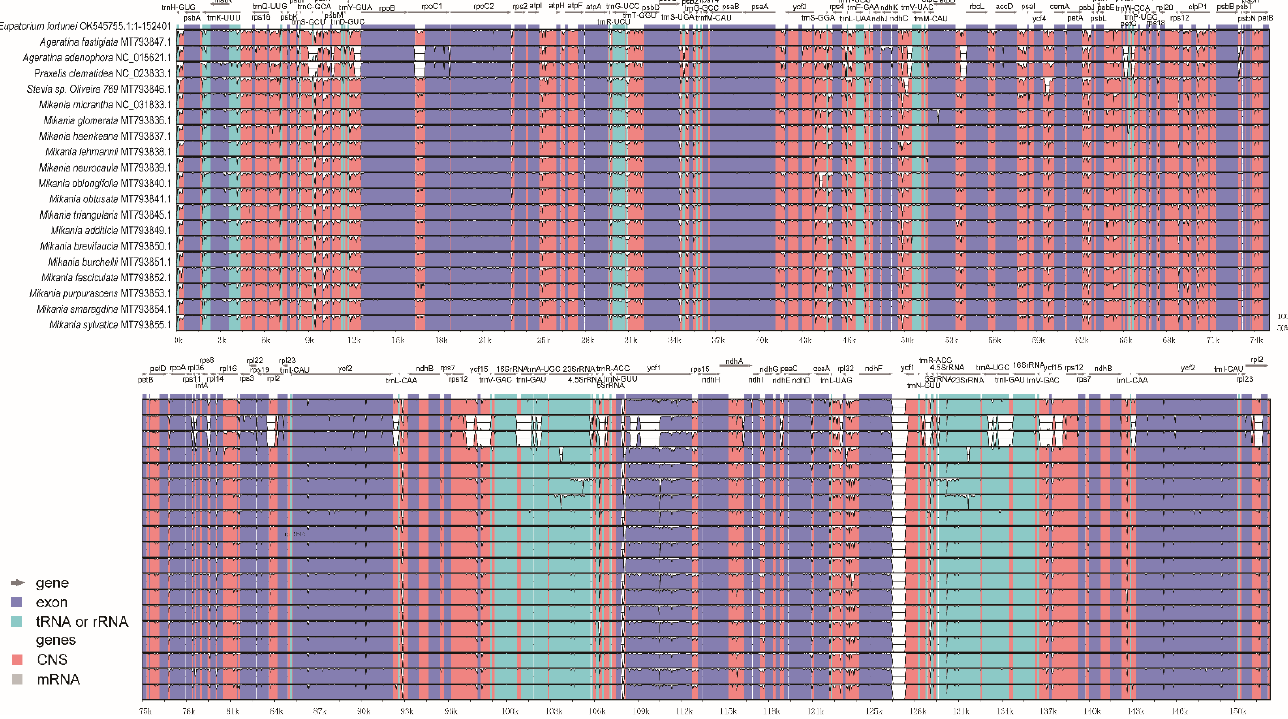
Figure 7. Percent identity plot for comparison of 19 Eupatorieae cp genomes using mVISTA. The x -axis represents the base sequence, and on the y -axis, percentage of sequence identity was shown between 50% and 100%. In contrast, coding exons and UTRs are marked with different colored rectangles. Conserved regions (defined below) are highlighted under the curves, red indicates conserved noncoding regions, blue indicates conserved exons, conserved UTRs are turquoise, and the direction of gene transcription is indicated by gray arrows. The pink bars represent noncoding sequences (CNS) while the purple bars represent exons.